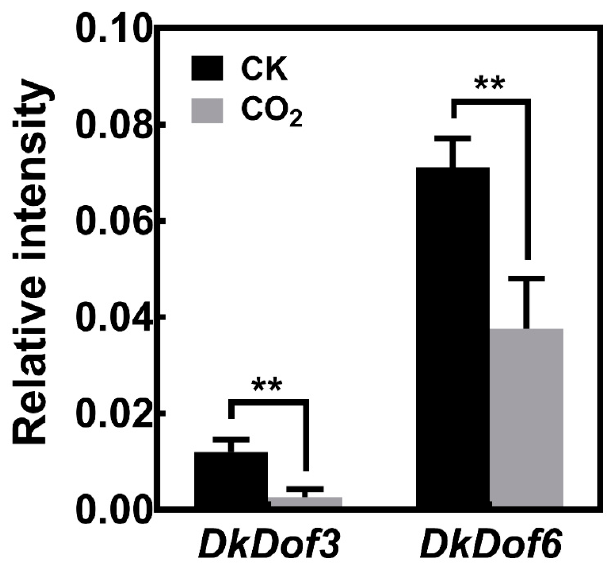
Figure 6. Expression of DkDof3 and DkDof6 after one day of high CO 2 treatment of ‘Jingmianshi’ fruit. DkACT was used as internal control. Error bars represent standard errors from three replicates (**, p < 0.01).